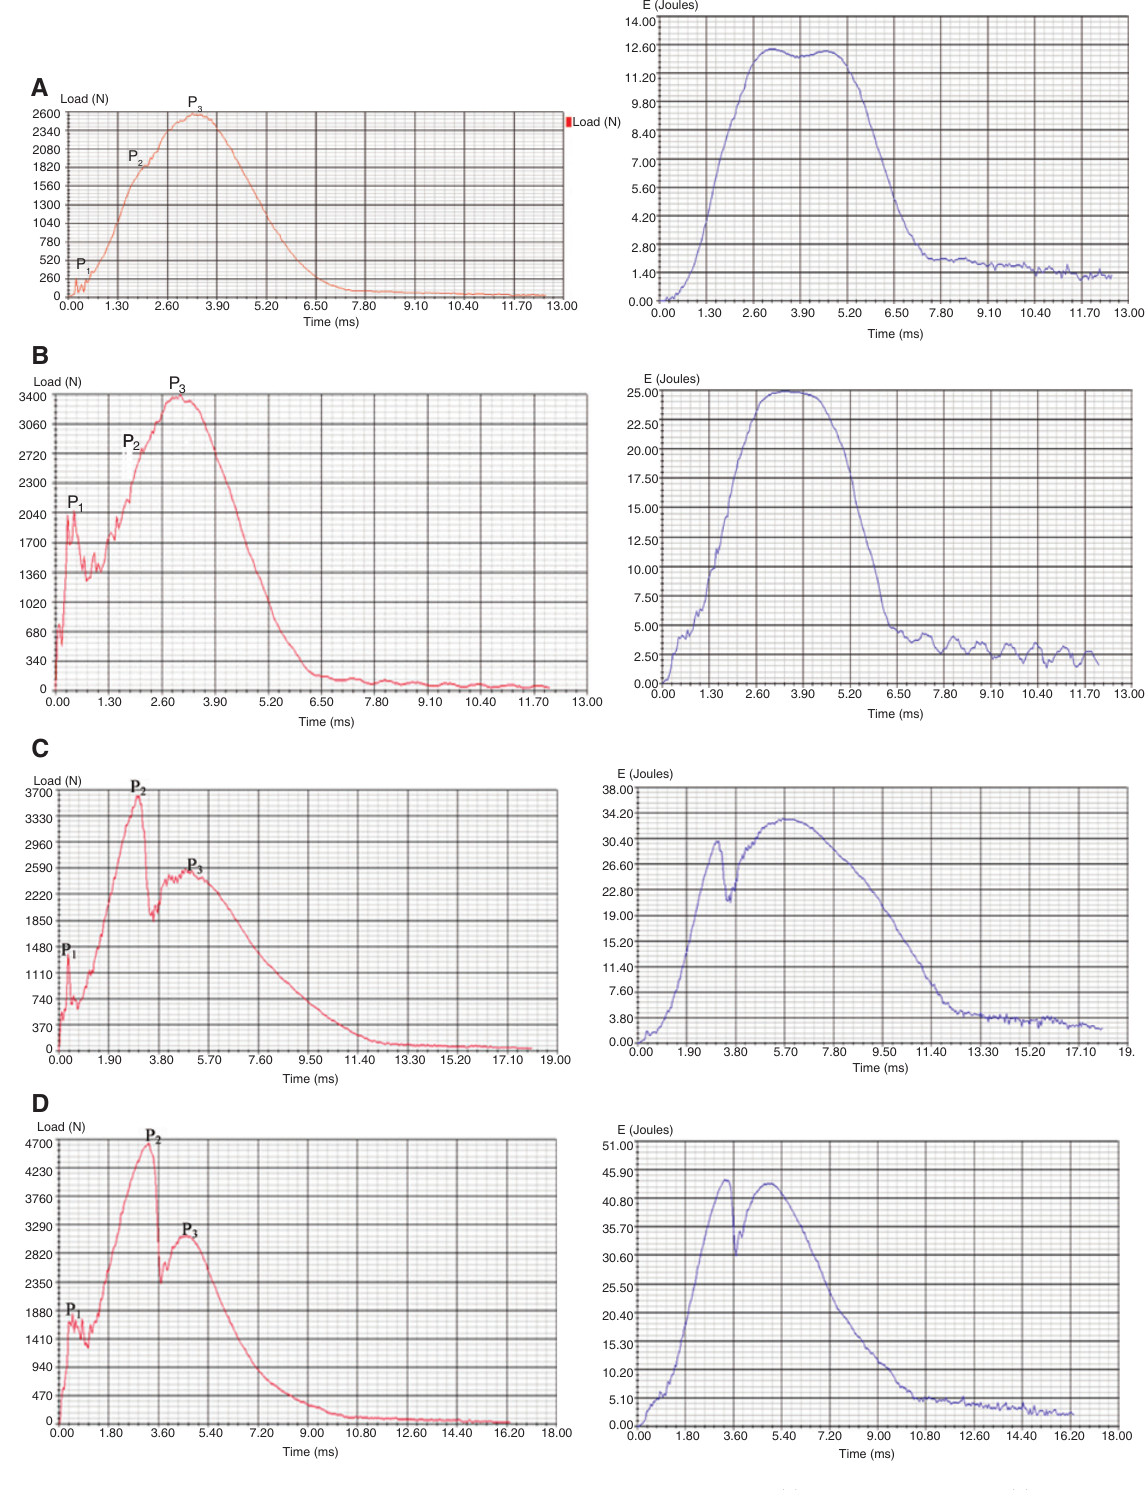
Figure 4 Load-time and energy-time plot for C8 panel at different impact energy levels. (A) Impact energy -12.64 J, (B) impact energy -25.27 J, (C) impact energy -37.64 J, (D) impact energy -50.19